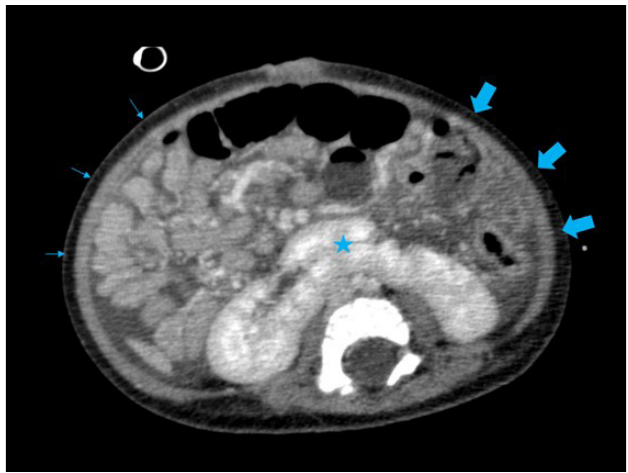
Fig. 5 - Axial computed tomography image showing horseshoe kidneys, with inferior poles (*) fused in the midline anterior to the abdominal aorta. In addition, all segments of small intestine (smoother walls and smaller caliber) positioned in their entirety in the right hemiabdomen (thin arrows), while the colonic segments are identified only in the left hemiabdomen (thick arrows), configuring intestinal